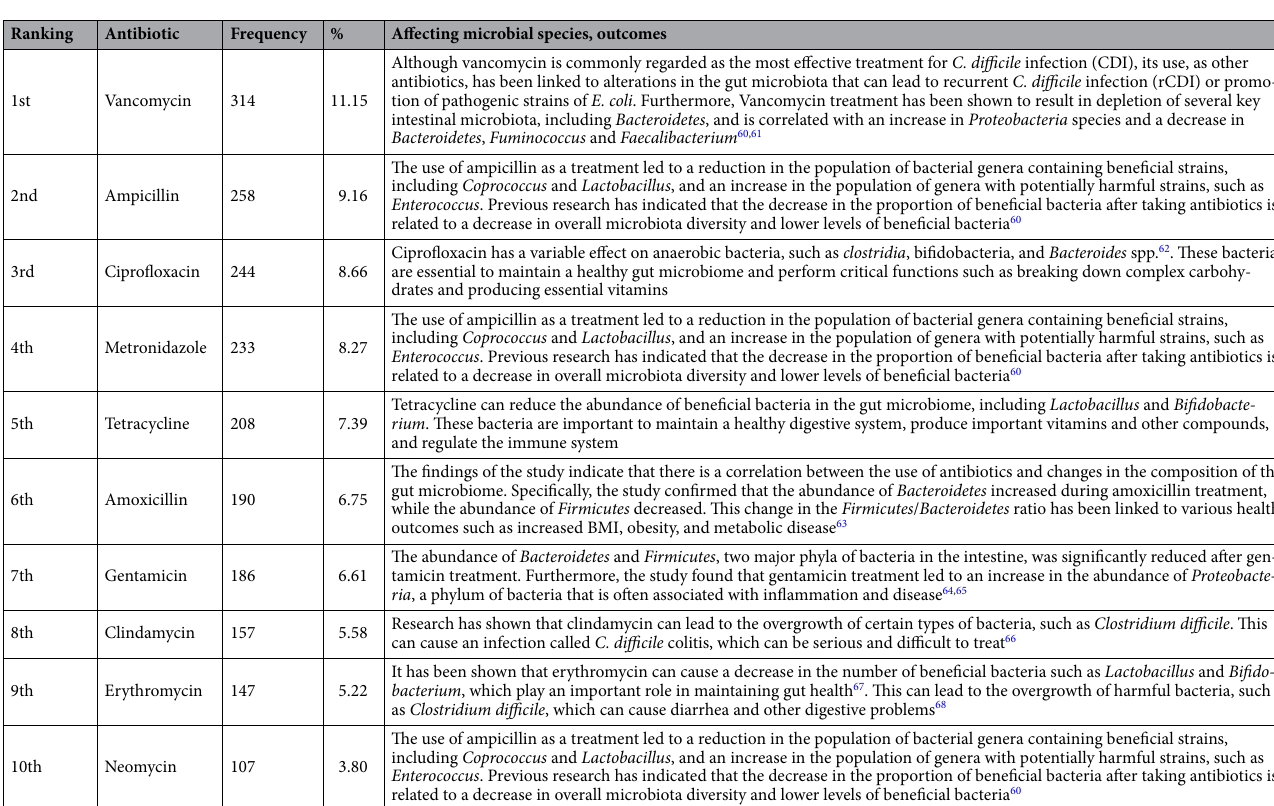
Table 6. List of the top ten frequent antibiotic occurrences in the microbiota literature from 2002 to